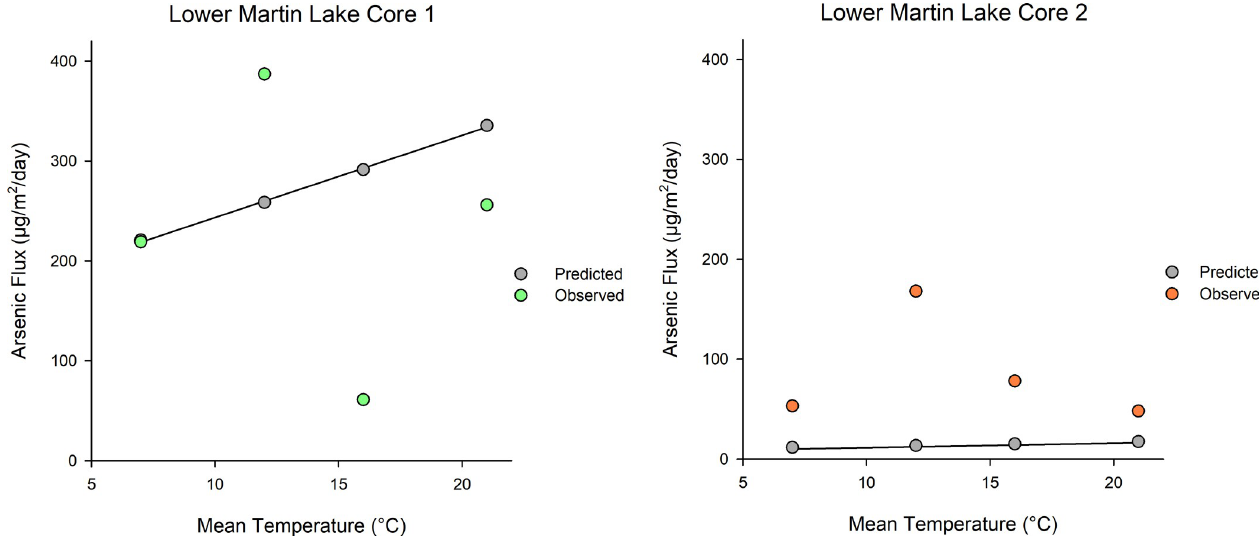
Fig 6. Predicted versus observed sediment arsenic fluxes in relation to temperature. Predicted As fluxes from Lower Martin Lake sediment (calculated using Fick’s law) for each temperature treatment in comparison to measured As fluxes in duplicate cores.